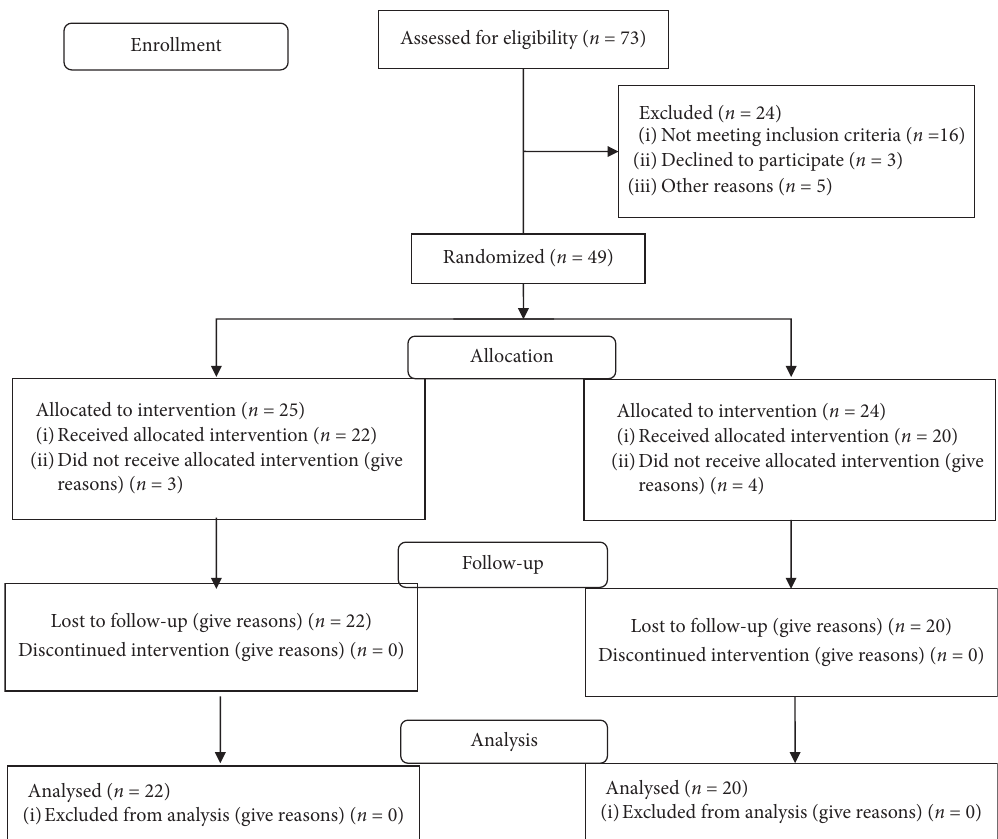
Figure 1: Flow diagram of subjects’